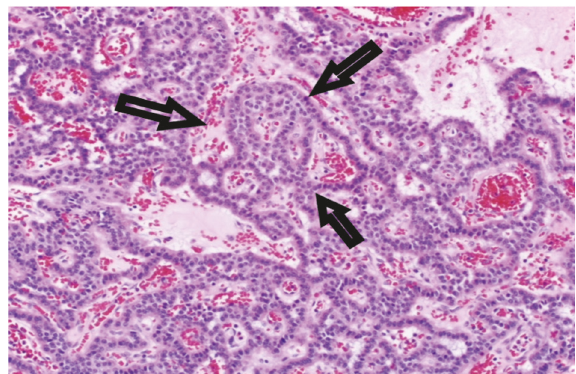
Figure 4: Histology showed a mass composed of trabeculae and solid nests of round, monotonous cells with crowded nuclei and stippled, open chromatin consistent with a cystic well-differentiated neuroendocrine tumor. Few mitotic figures were identified within the